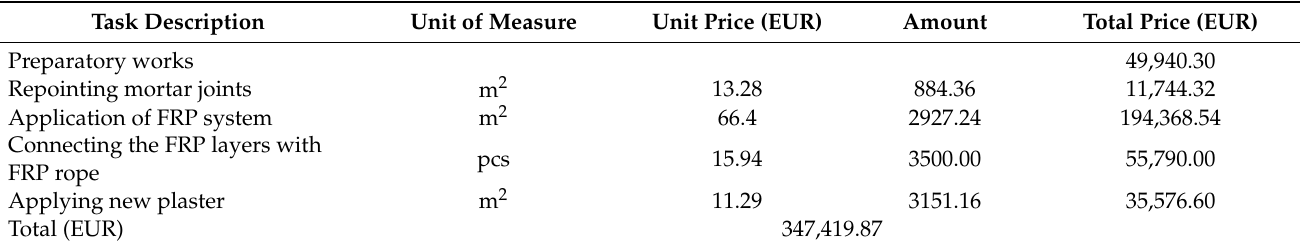
Table 11. Calculation of renovation costs—FRP composite system.